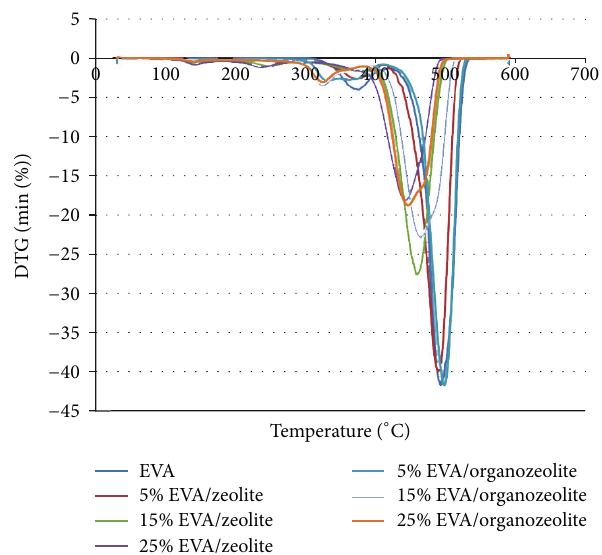
Figure 10: The DSC thermograms of unmodified and organozeolite filled EVA composites with different zeolite contents.